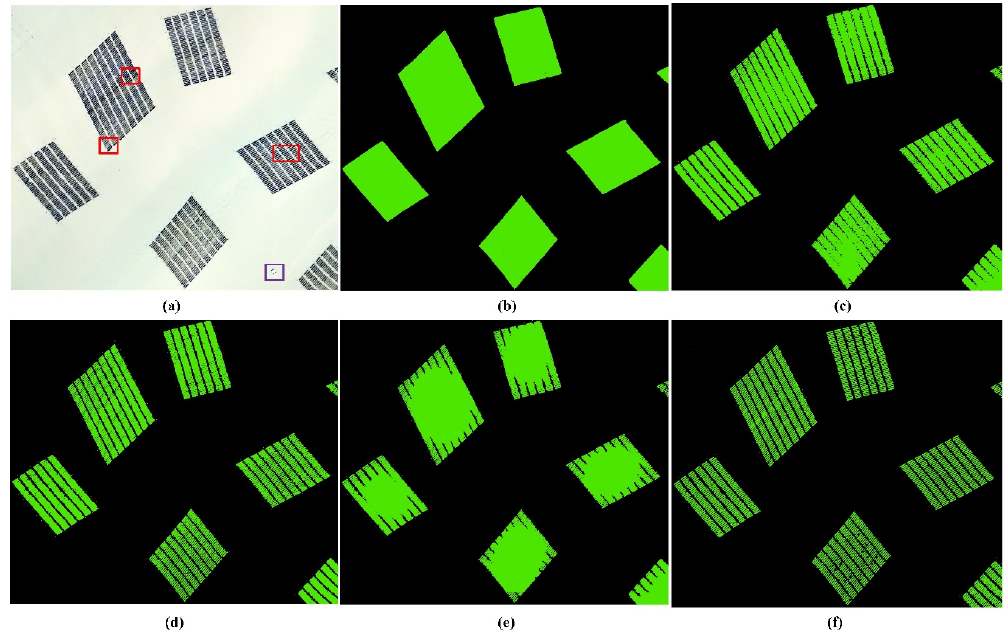
Figure 10. Comparison of CRF with different parameters. ( a ) Remote sensing image; ( b ) The result of FCN; ( c ) The result of CRF_1; ( d ) The result of CRF_2; ( e ) The result of CRF_3; ( f ) The result of CRF_4.